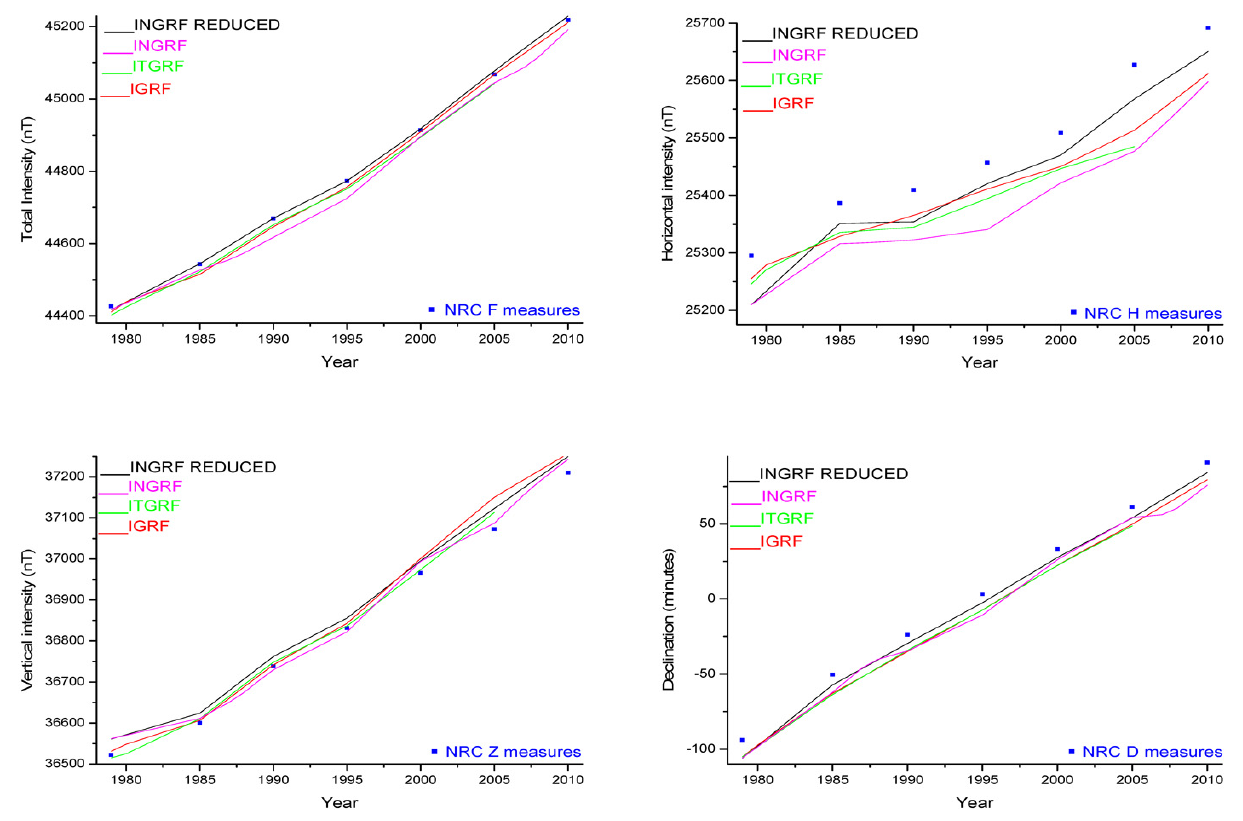
Figure 10. Measures of F, H, Z, D at NRC station (squares) together with the values predicted by various models (coloured